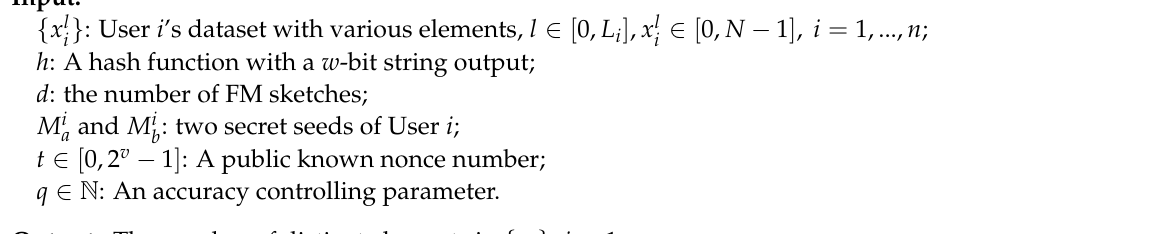
Algorithm 1 Privacy-preserving Distinct Counting